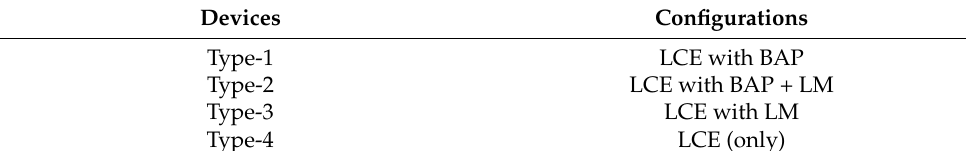
Table 1. The configurations of LCE devices with different photothermal films.